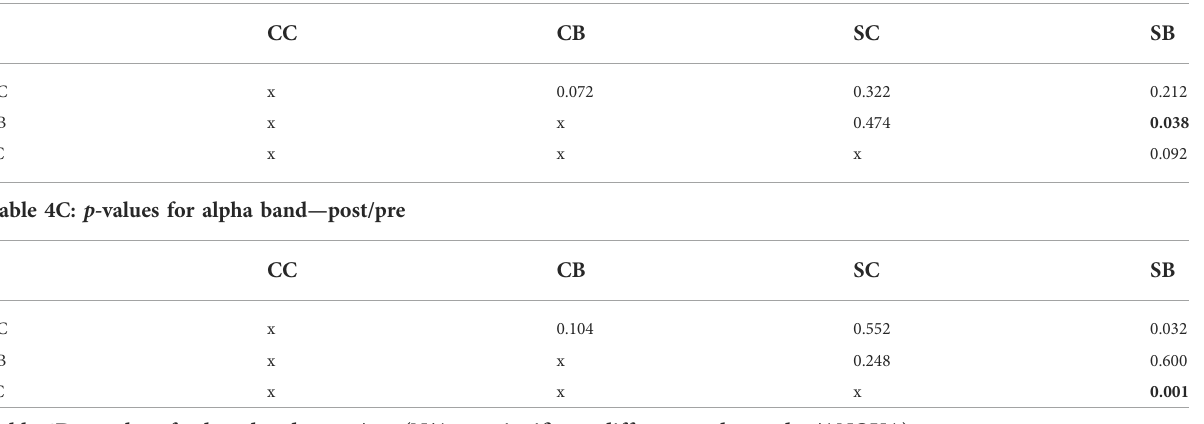
TABLE 4 Post hoc results comparing EEG band powers between pairs of visual feedback modes. Table 4A: p -values for alpha band — training/pre (N/A, no signi fi cant differences observed w/ANOVA) Table 4B: p -values for beta band — training/pre ( post hoc results shown given signi fi cant interaction)